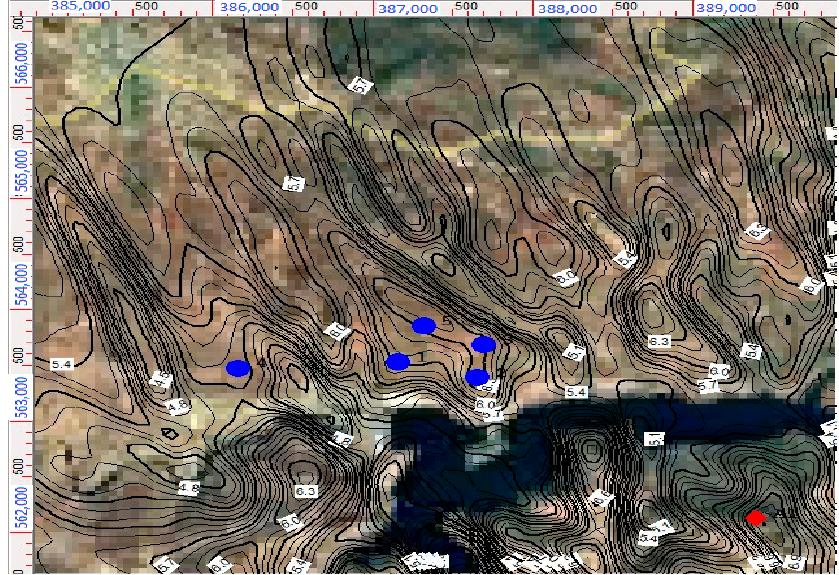
Figure 9. Position of the wind turbines after optimization on wind speed map.